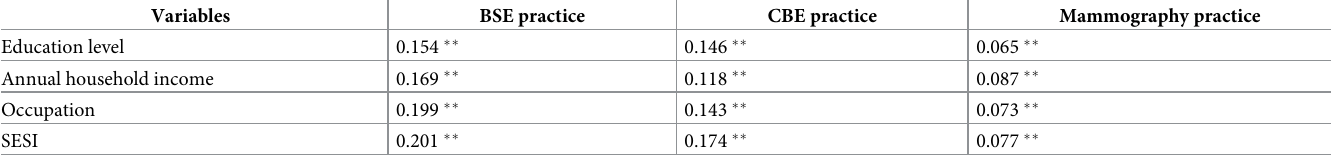
Table 3. Bivariate correlations between socioeconomic factors and breast cancer screening practices (n =